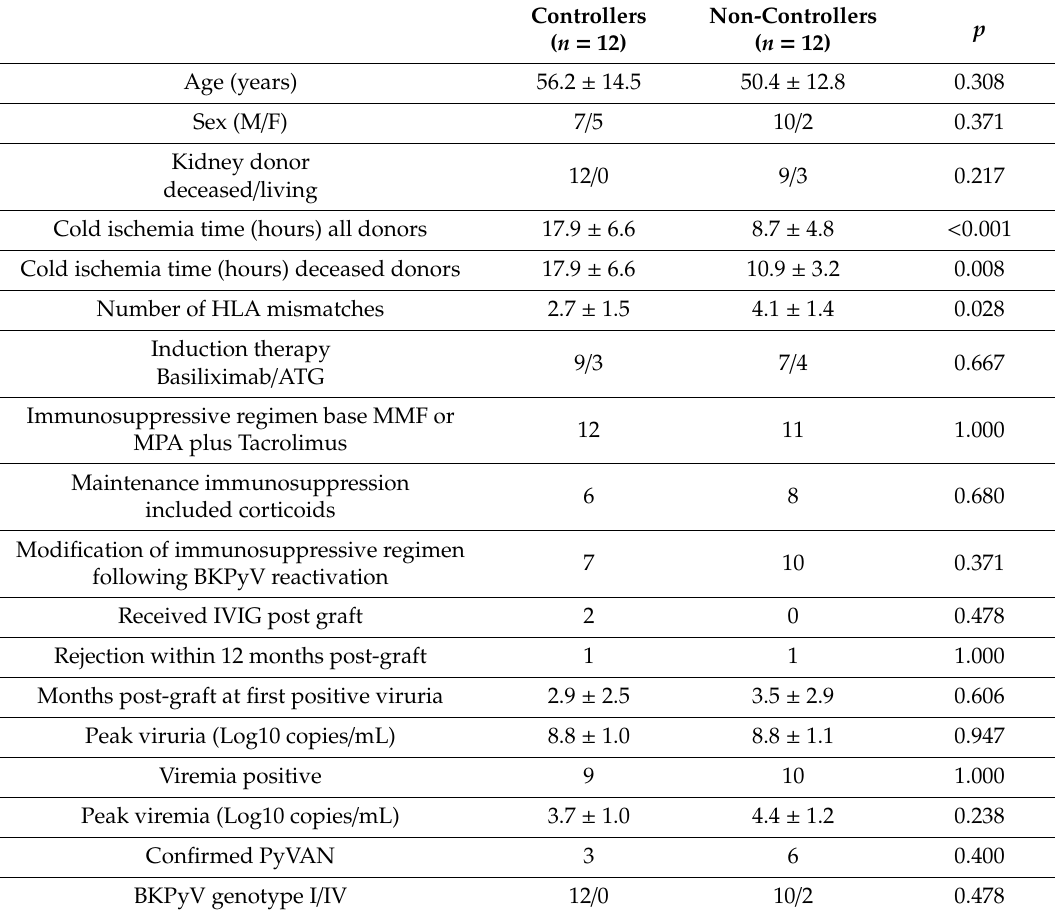
Table 1. Clinical and biological characteristics of BKPyV Controller and Non-controller groups. For continuous variables, mean ± standard deviation are shown for each group. Means were compared by unpaired Student t-test, and categorical variables were compared by Fisher’s exact test.